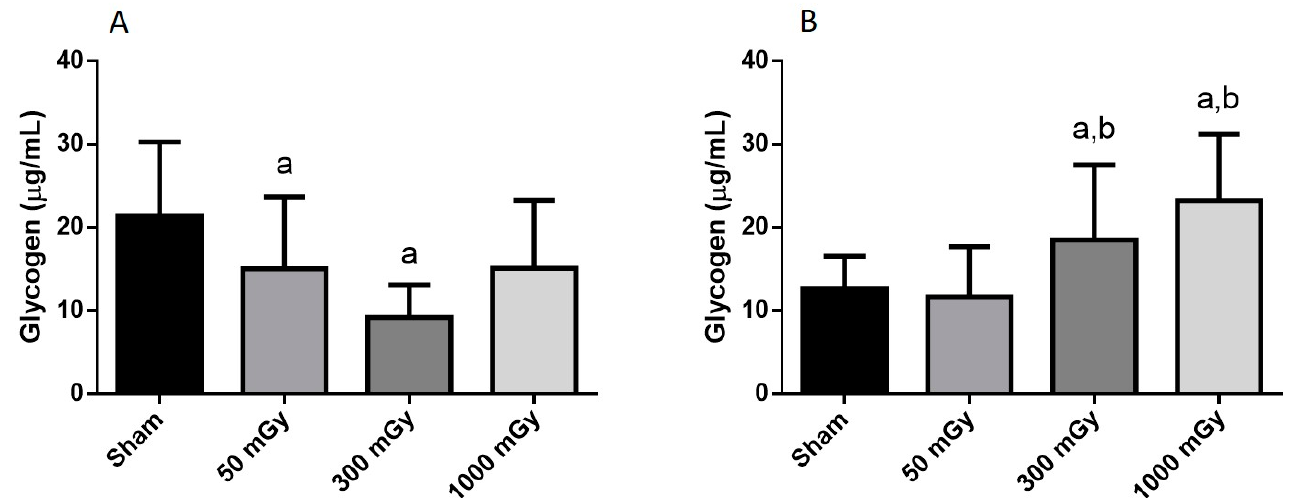
Figure 2. Cardiac glycogen content. ( A ) male and ( B ) female offspring cardiac glycogen levels. Data are expressed as mean ± SEM. a—is significantly different as compared to Sham, and b—is significantly different as compared to 50 mGy, p ≤ 0.05. n = 11–19 per group.